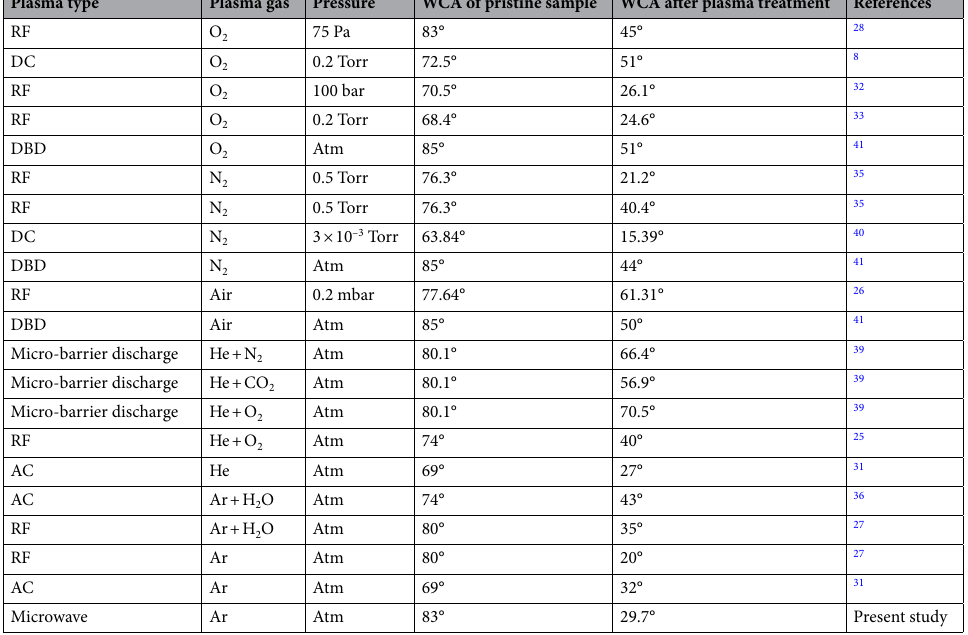
Table 1. Comparison of the plasma-based techniques for hydrophilicity improvement of PMMA polymer